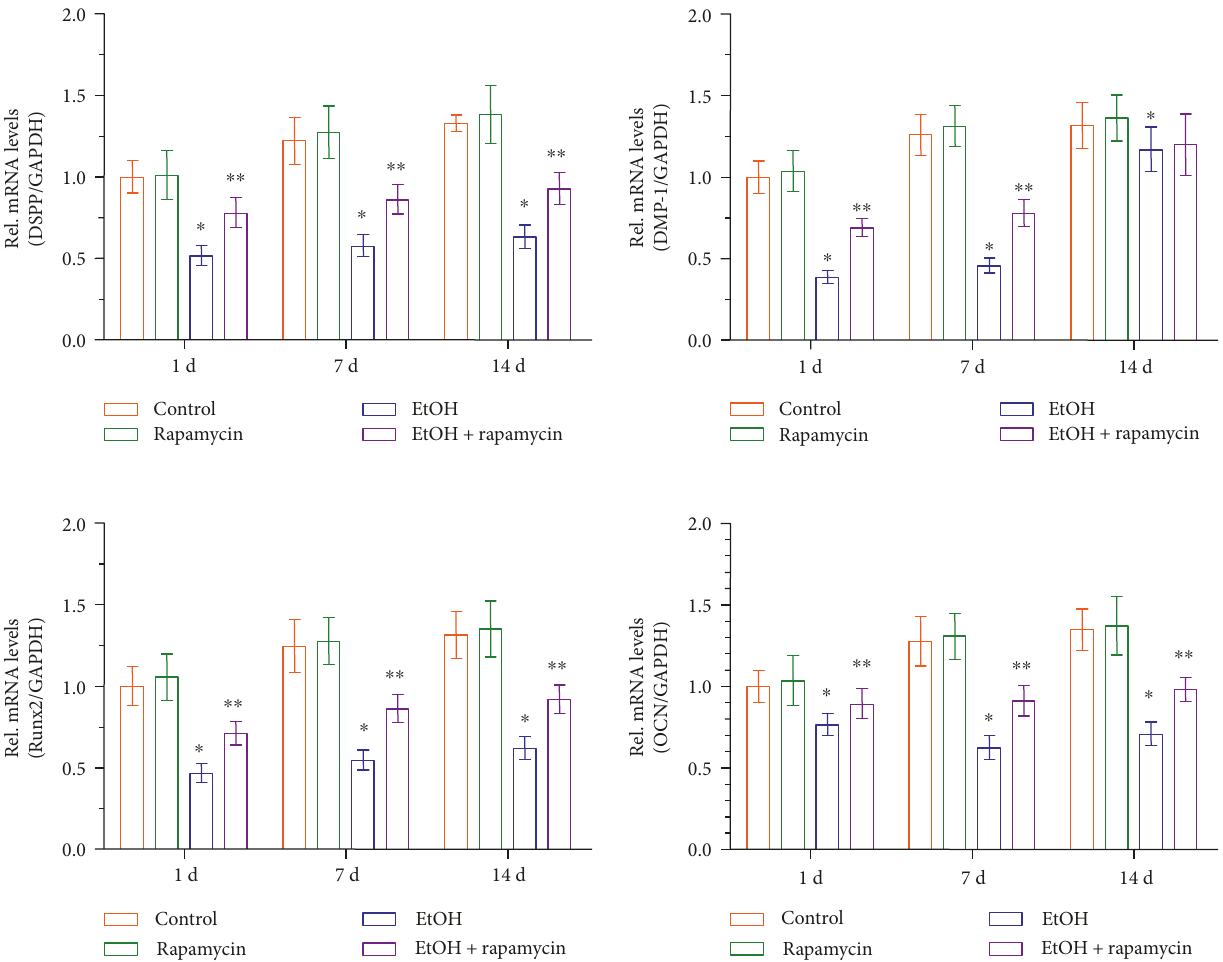
Figure 5: E ff ects of EtOH treatment on the odontoblastic di ff erentiation of DPCs. DPCs cells were pre-incubated with rapamycin (50 mM) for 1 hour before treatment with EtOH. The mRNA expression of DSPP, DMP-1, Runx2, and OCN was analyzed using real-time RT-PCR. Data represent mean ± SD of 3 experiments with triplicates. ∗ p < 0 05 versus control group. ∗∗ p < 0 05 versus EtOH